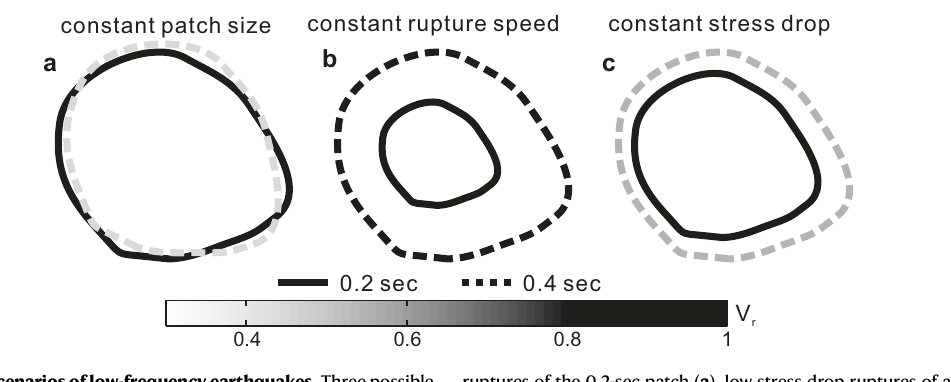
ruptures of the 0.2-sec patch ( a ), low stress drop ruptures of a much larger patch ( b ), or slow ruptures of a partially adjacent patch ( c ). Scenario ( c ) could be viewed as a combination of a , b . Colors of boundaries indicate rupture speed ( V r ).